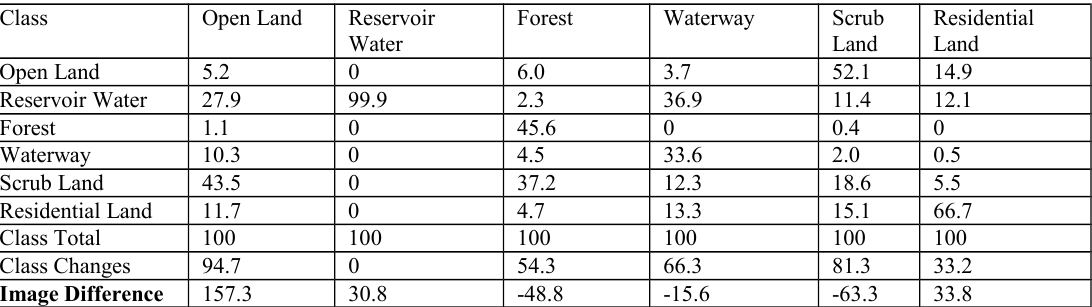
Table 5: Spring to Summer Season Change Detection Percentage